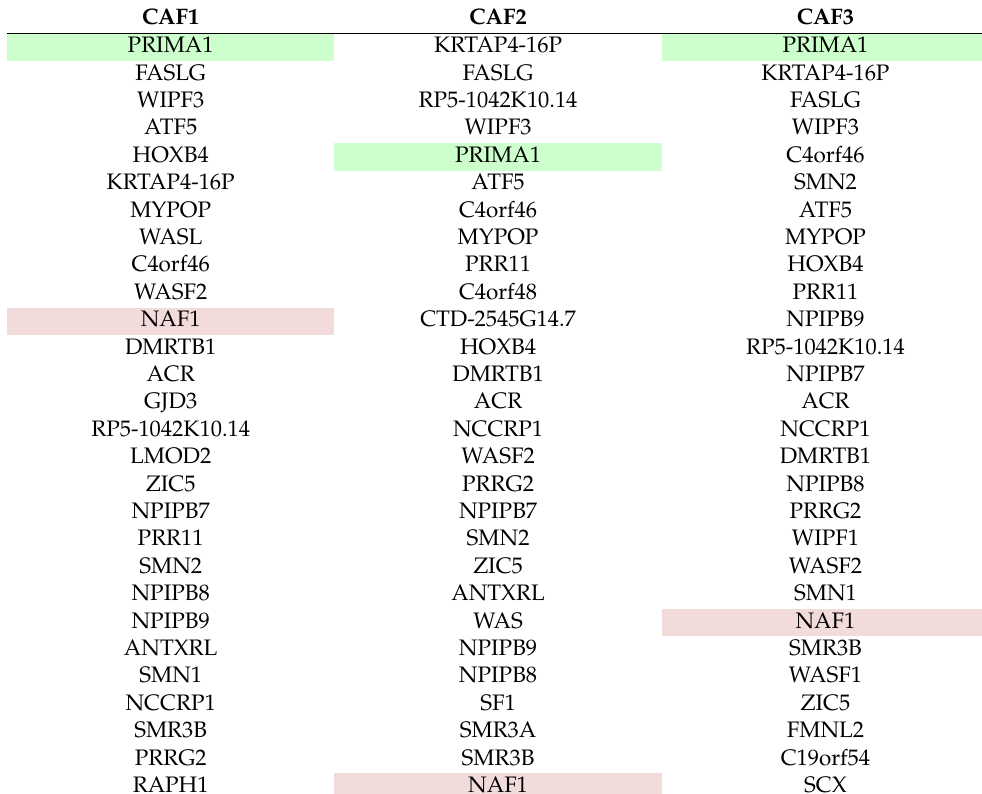
Table 2. Lists of the first ranked proteins (named by gene symbol, BioInfoMiner) mapped by peptides of three CAF repertoires (PAM30 threshold 0.68). Color-highlighted proteins refer to examples retaken in Figure 4 showing the mapping